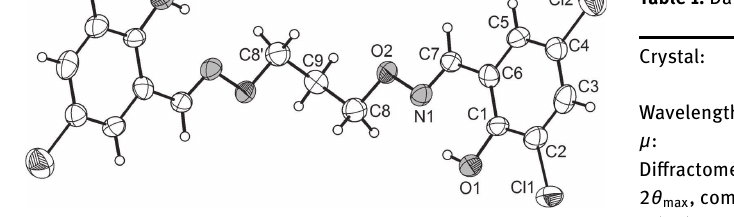
Table 1: Data collection and handling.